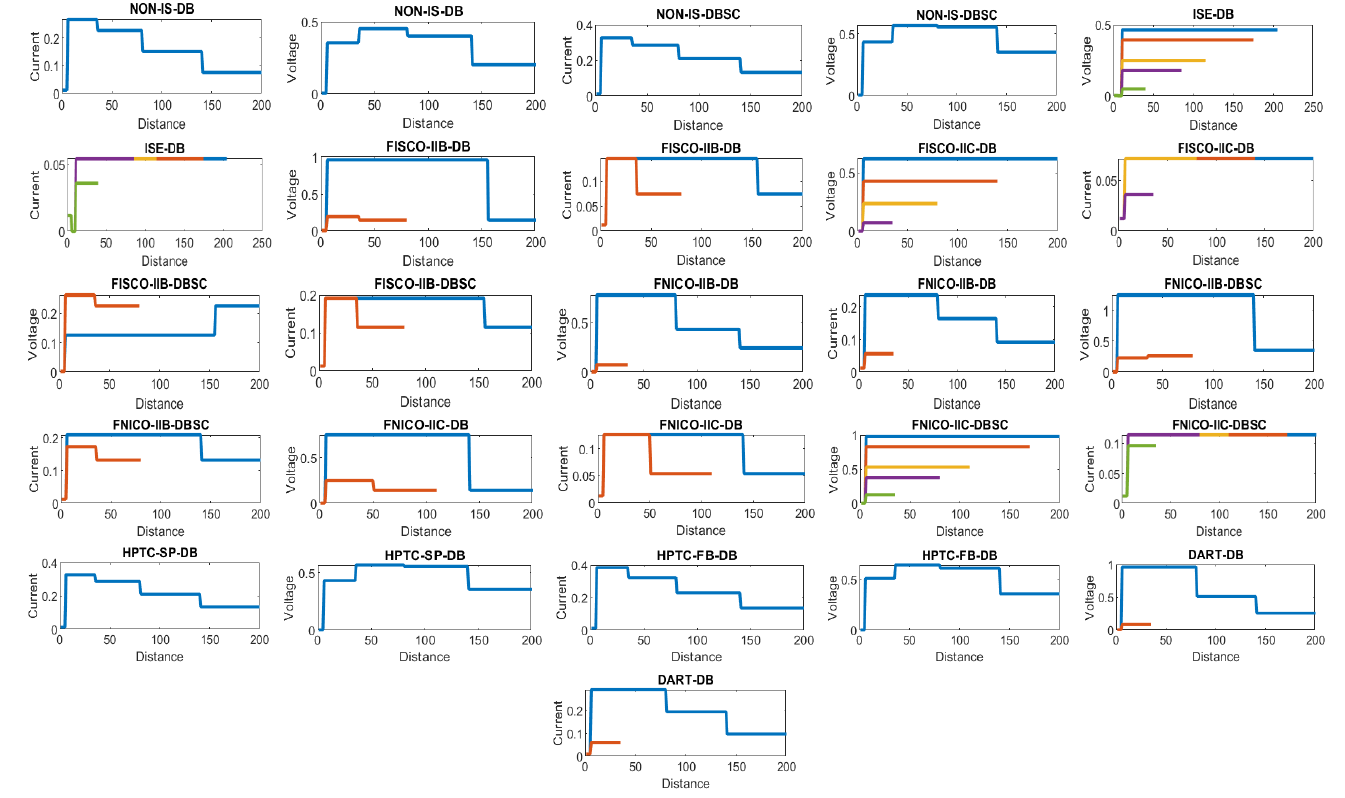
Figure 9. Current and voltage drop on the cables included in sub-models dedicated to double bottom tanks. Blue, brown, yellow, violet and green colors refer to segments from 1 to 5, respectively.